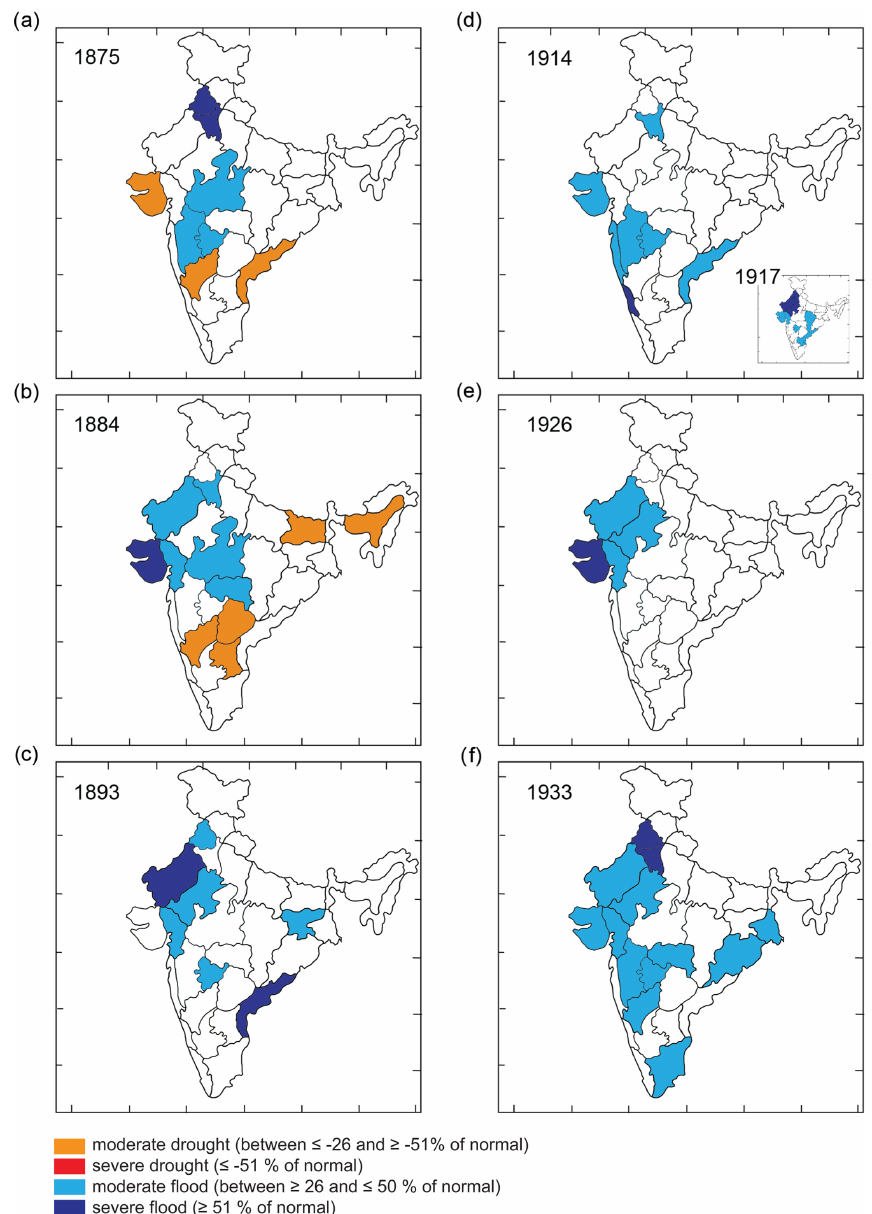
Figure 8. The distribution of meteorological subdivisions in NW India reporting flood conditions during periods of low spectral intensity at a = 27